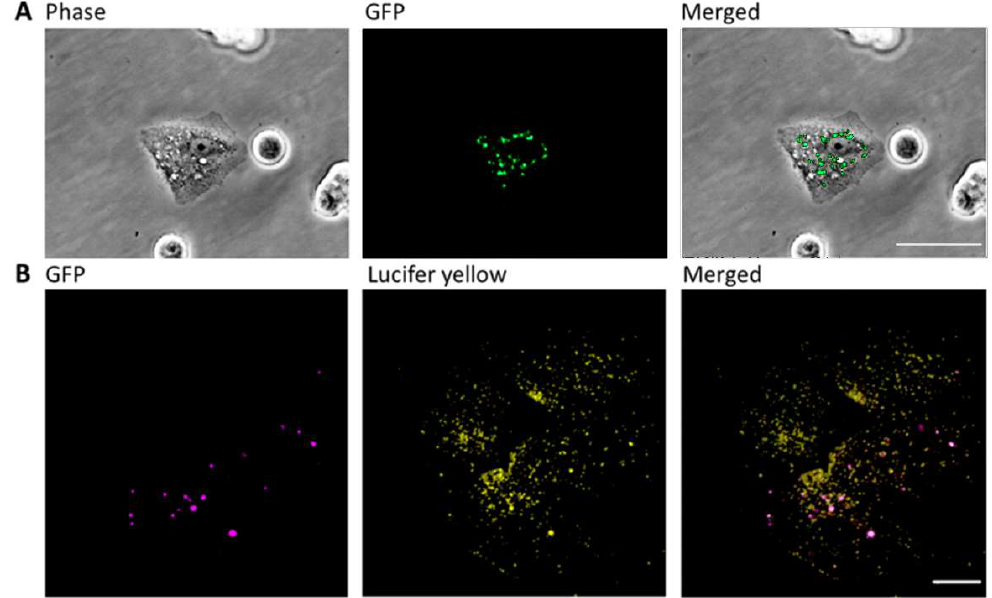
Figure 4. Analysis of vacuoles and autophagosomes in MCF7 cells. ( A ) MCF7 cells stably transfected with GFP-tagged microtubule-associated protein 1 light chain II (LC3II) were incubated with JB (10 µM, 2 h). Vacuoles were observed under a phase microscopy and autophagosomes, labeled with GFP, were analyzed by fluorescence microscopy. Scale bar: 50 µm. ( B ) MCF7 cells stably transfected with GFP-tagged LC3II were incubated with 10 µM JB and 0.5 mg/ml Lucifer yellow (LY) for 2 h and analyzed by confocal microscopy. Images are representative of at least two experiments. Scale bar: 10 µm.